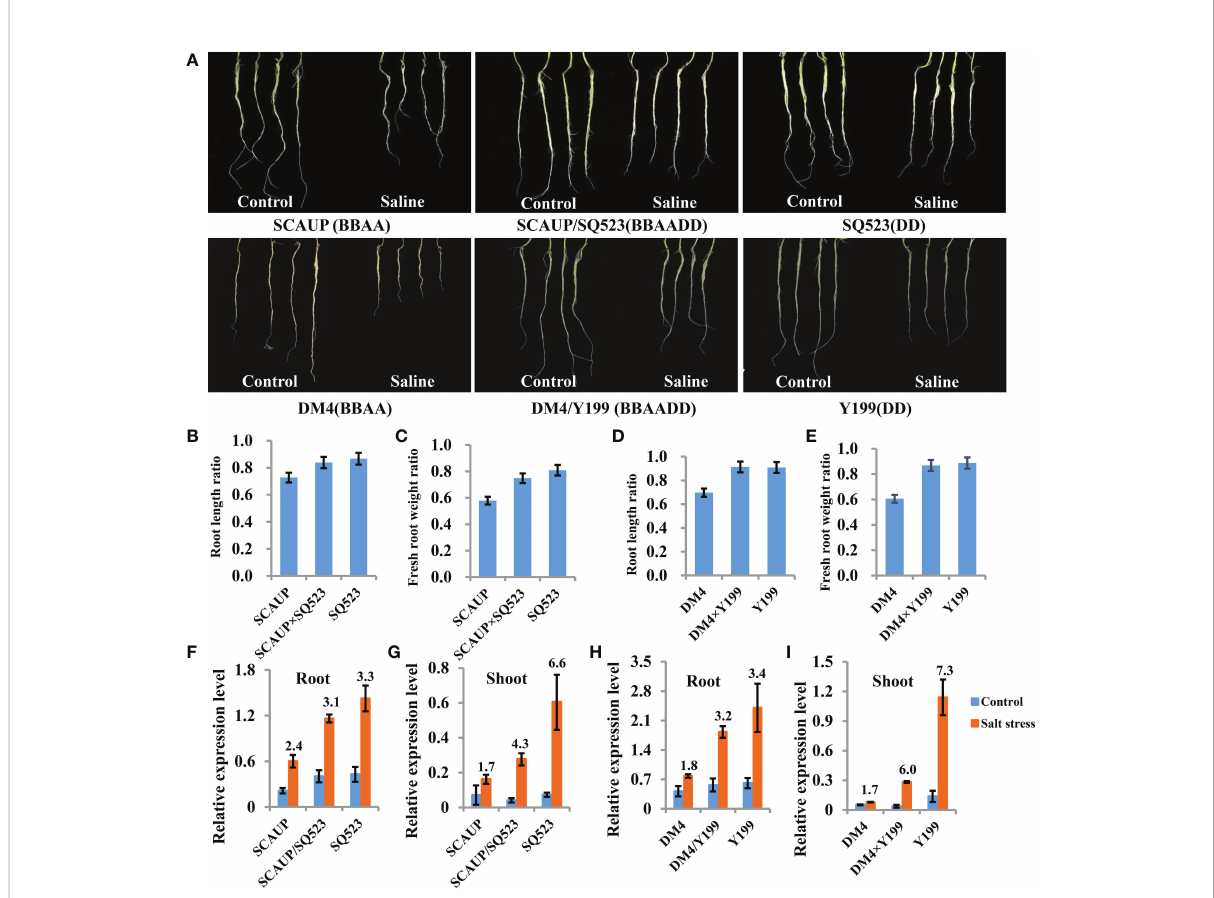
FIGURE 3 Salt stress phenotypes and transcript level of SOS1 genes in synthetic allopolyploid wheats and their parents. Seedlings of the two set of synthetic hexaploids with their tetraploid and diploid parents were fi rst grown for 10 d without NaCl treatment. The plants were then grown under control conditions (Control) or treated with 200 mM NaCl solution (Saline); phenotypes were measured and photographed after 7 d. SCAUP/SQ523 and DM4/Y199, synthetic allohexaploid wheats, BBAADD; SCAUP and DM4, tetraploid parents, BBAA; SQ523 and Y199, diploid parents, DD. (A) Root phenotypes of with tetraploid and diploid parents upon NaCl treatment. (B-E) Quanti fi cation of root length (B, D) and fresh weight (C, E) of two synthetic allotetraploid wheats and their tetraploid and diploid parents. Mean and SD values were derived from measurements of at least 20 seedlings from three independent assays. (F-I) qRT ‐ PCR analysis of SOS1 genes in roots (F, H) and shoots (G, I) of two set of synthetic hexaploids with their tetraploid and diploid parents in response to salt stress. Seven-day-old seedling plants were subjected to 0 mM or 9h after 200 mM NaCl treatment for root or after 2 days of 200 mM NaCl treatment for shoot. The expression of b -Actin was used to normalize mRNA levels. The values are means (± SE) of three biological